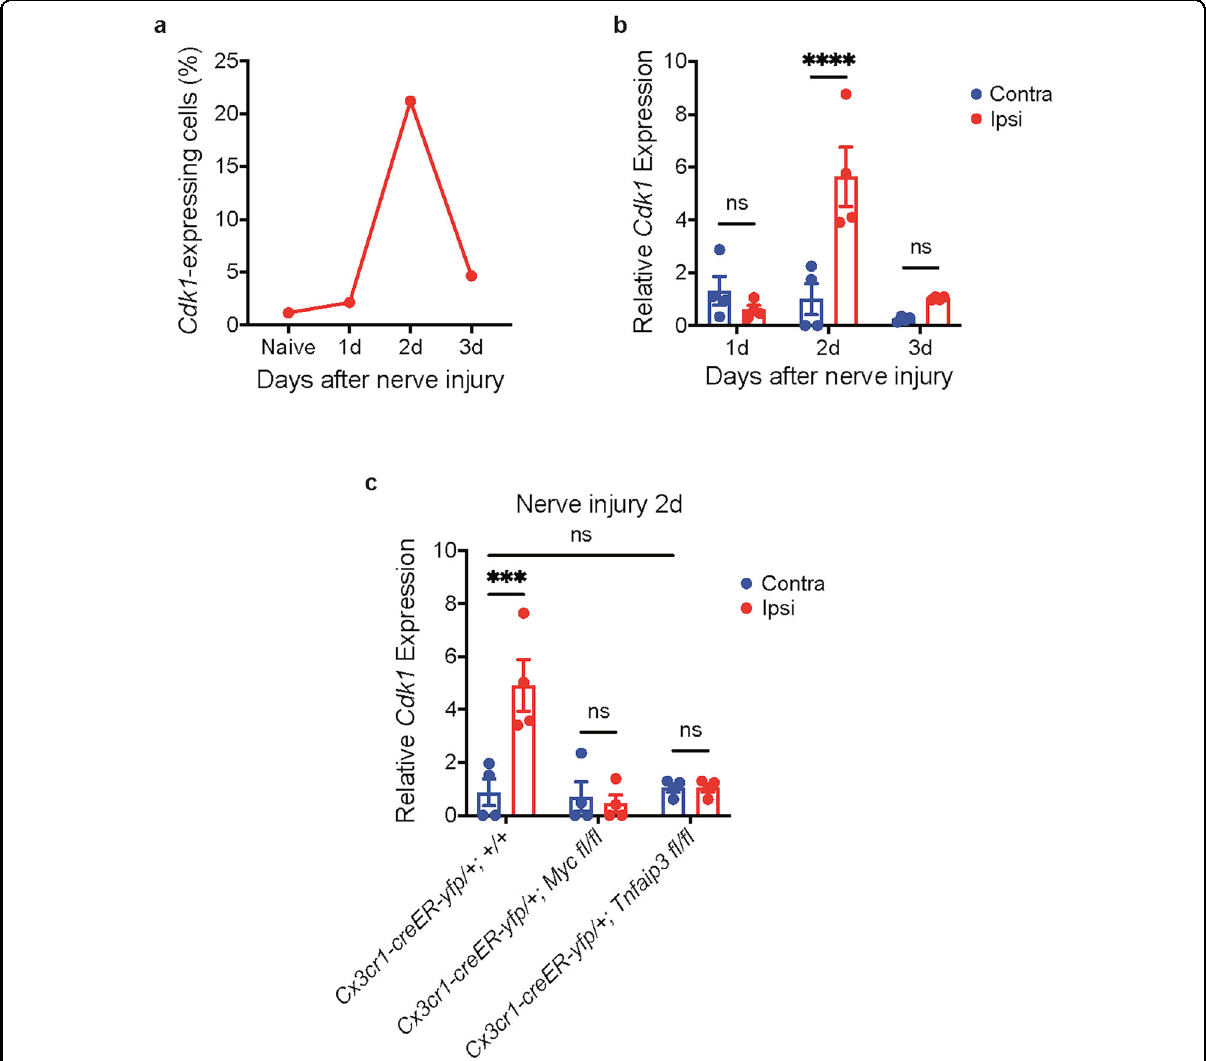
Fig. 5 Signaling pathways in microglia proliferation. a Proportion of microglia cells expressing Cdk1 from scRNA-Seq analysis. Cdk1 was expressed in a higher proportion of microglia 2 days after nerve injury. b qRT-PCR of sorted microglia from lumbar spinal cord of Cx3cr1-creER-yfp/ + ; + / + animals. Cdk1 was upregulated in microglia from ipsilateral lumbar cord 2 days, but not 1 day or 3 days, after nerve injury. c qRT-PCR of sorted lumbar cord microglia. Cdk1 upregulation in microglia 2 days after nerve injury was prevented when Myc was deleted from adult microglia. Deleting Tnfaip3 from adult microglia did not induce Cdk1 upregulation. Deletion of Tnfaip3 also prevented Cdk1 upregulation 2 days after nerve injury. Analyses are two-way ANOVA with Sidak ’ s multiple-comparison test, n = 4 – 6, means ± SEM, *** P < 0.001, **** P < 0.0001; ns, not signi fi